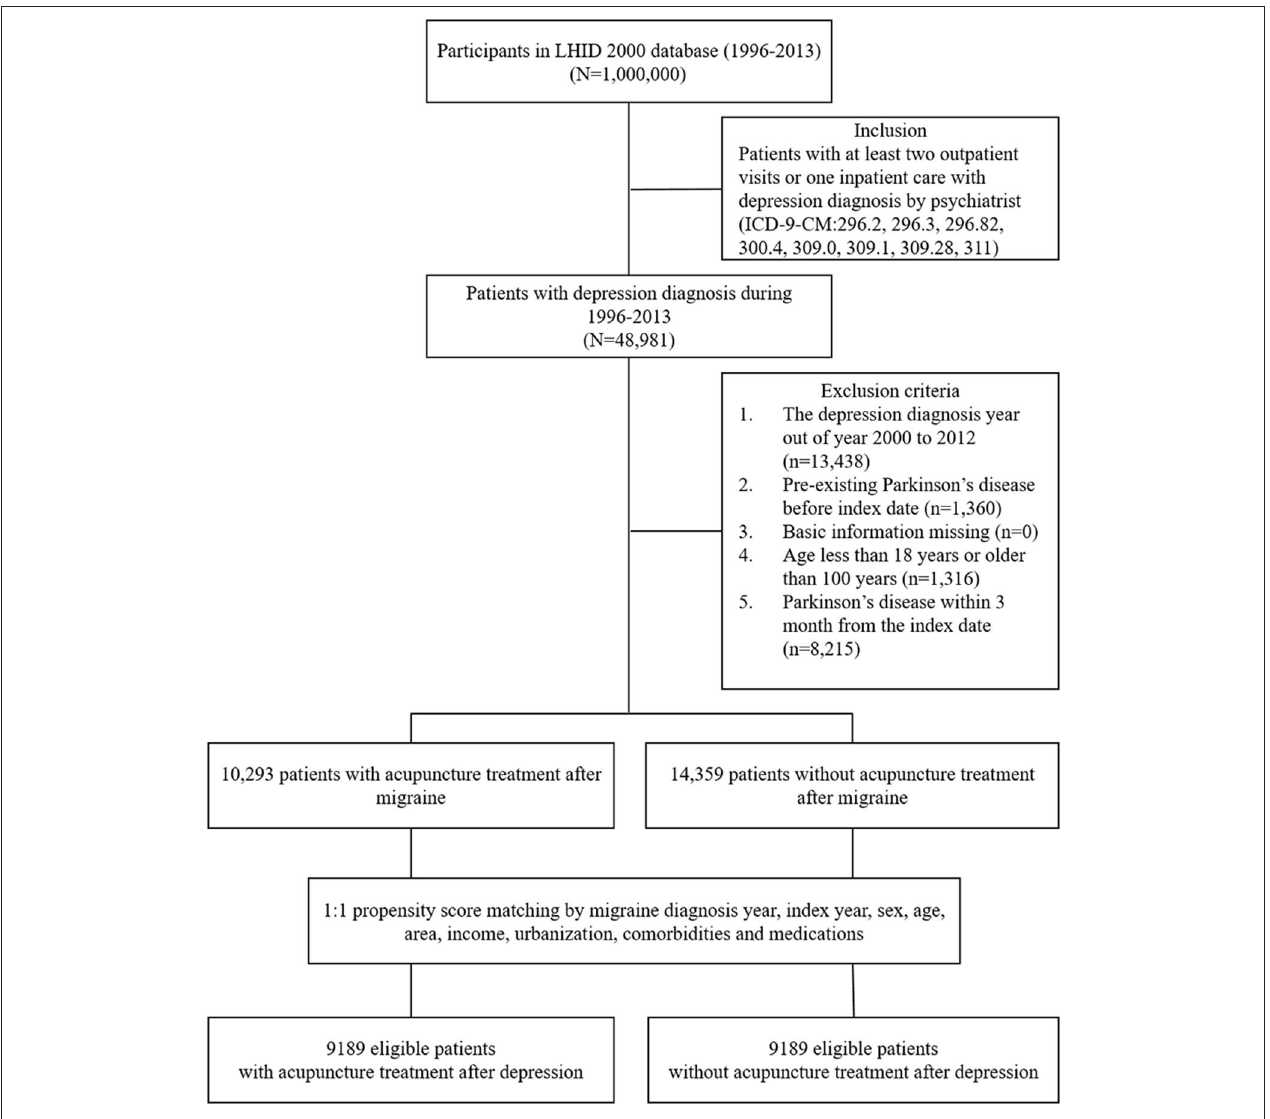
FIGURE 1 | Study population flowchart. We identified 48,981 eligible newly diagnosed depression patients between 1996 and 2013. After using the 1:1 propensity score to match by sex, age, comorbidities, and drugs used, the groups of acupuncture users and acupuncture non-users each contained 9,189 patients. LHID 2000, Longitudinal Health Insurance Database 2000, NHI, National Health